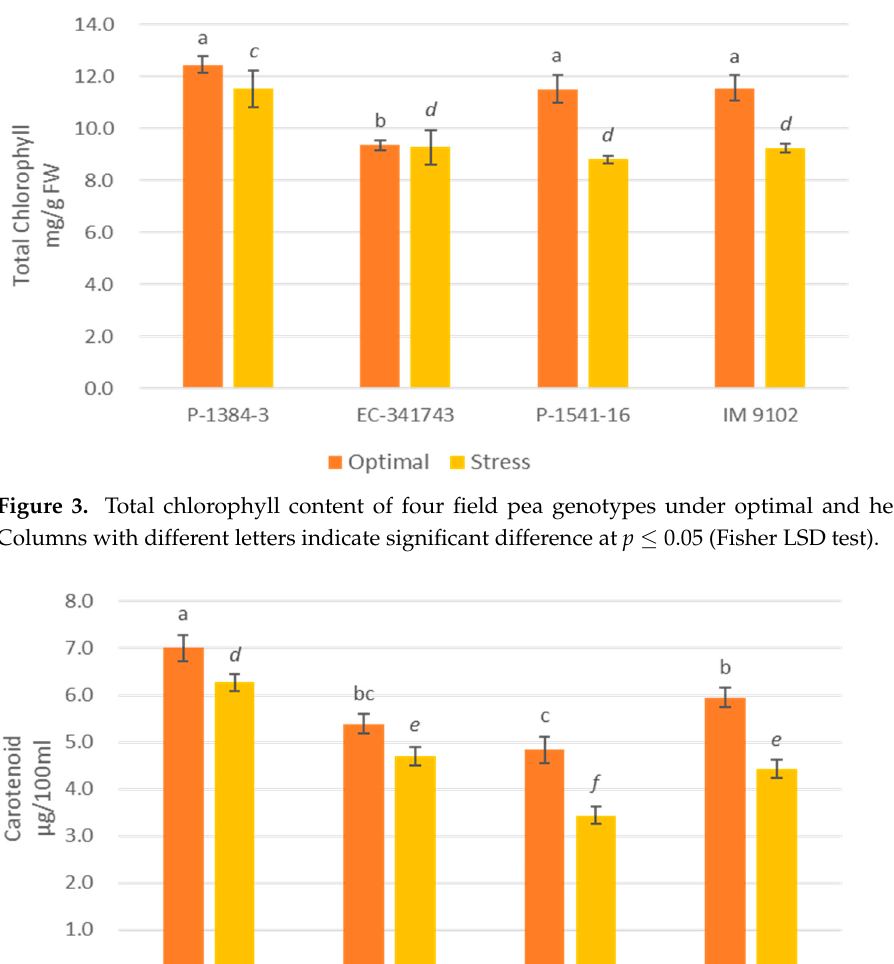
Figure 2. Chlorophyll-b content of four field pea genotypes under optimal and heat stress. Columns with different letters indicate significant difference at p ≤ 0.05 (Fisher LSD test).